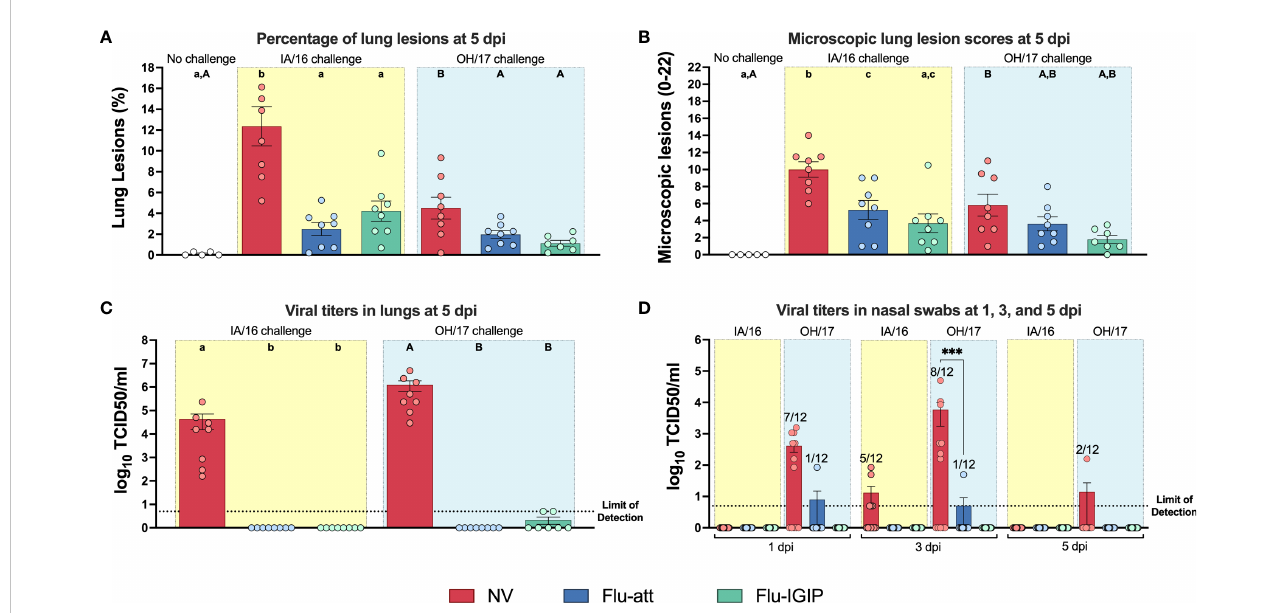
FIGURE 5 Lung lesions and virus titers in challenged pigs. Non-vaccinated pigs (NV, red bars) or pigs vaccinated with bivalent Flu- att (blue bars) or Flu-IGIP (green bars) were challenged with A/swine/Iowa/A01778877/2016 (IA/16 H1N1, light-yellow boxes) or A/swine/Ohio/A01354299/2017 (OH/17 H3N2, light-blue boxes). (A) Macroscopic and (B) microscopic pneumonia. Results displayed as mean percentage macroscopic consolidation or microscopic scores of lungs ± standard error of the mean. Viral titers in (C) bronchoalveolar lavage fl uid (BALF) collected at 5 days post inoculation (dpi) or (D) nasal swabs collected at 1, 3, and 5 dpi. Results displayed as mean viral titers ± standard error of the mean. Different uppercase (OH/17 challenge) or lowercase (IA/16 challenge) letters indicate statistical differences within groups challenged with the same virus (only groups challenged with same virus were compared between each other). ***, p ≤ 0.001 within groups challenged with the same virus. Dotted lines indicate limit of detection.